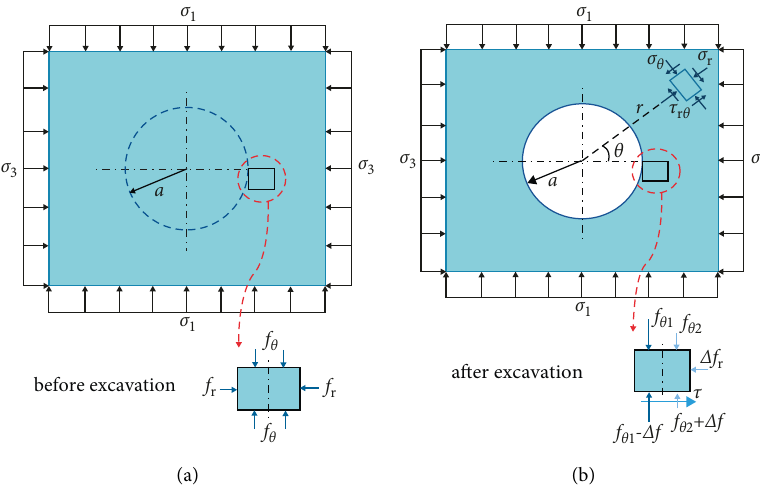
Figure 5: Stress changes of surrounding rock element before and after model excavation. (a) Stress state of surrounding rock element before model excavation. (b) Stress state of surrounding rock element after model